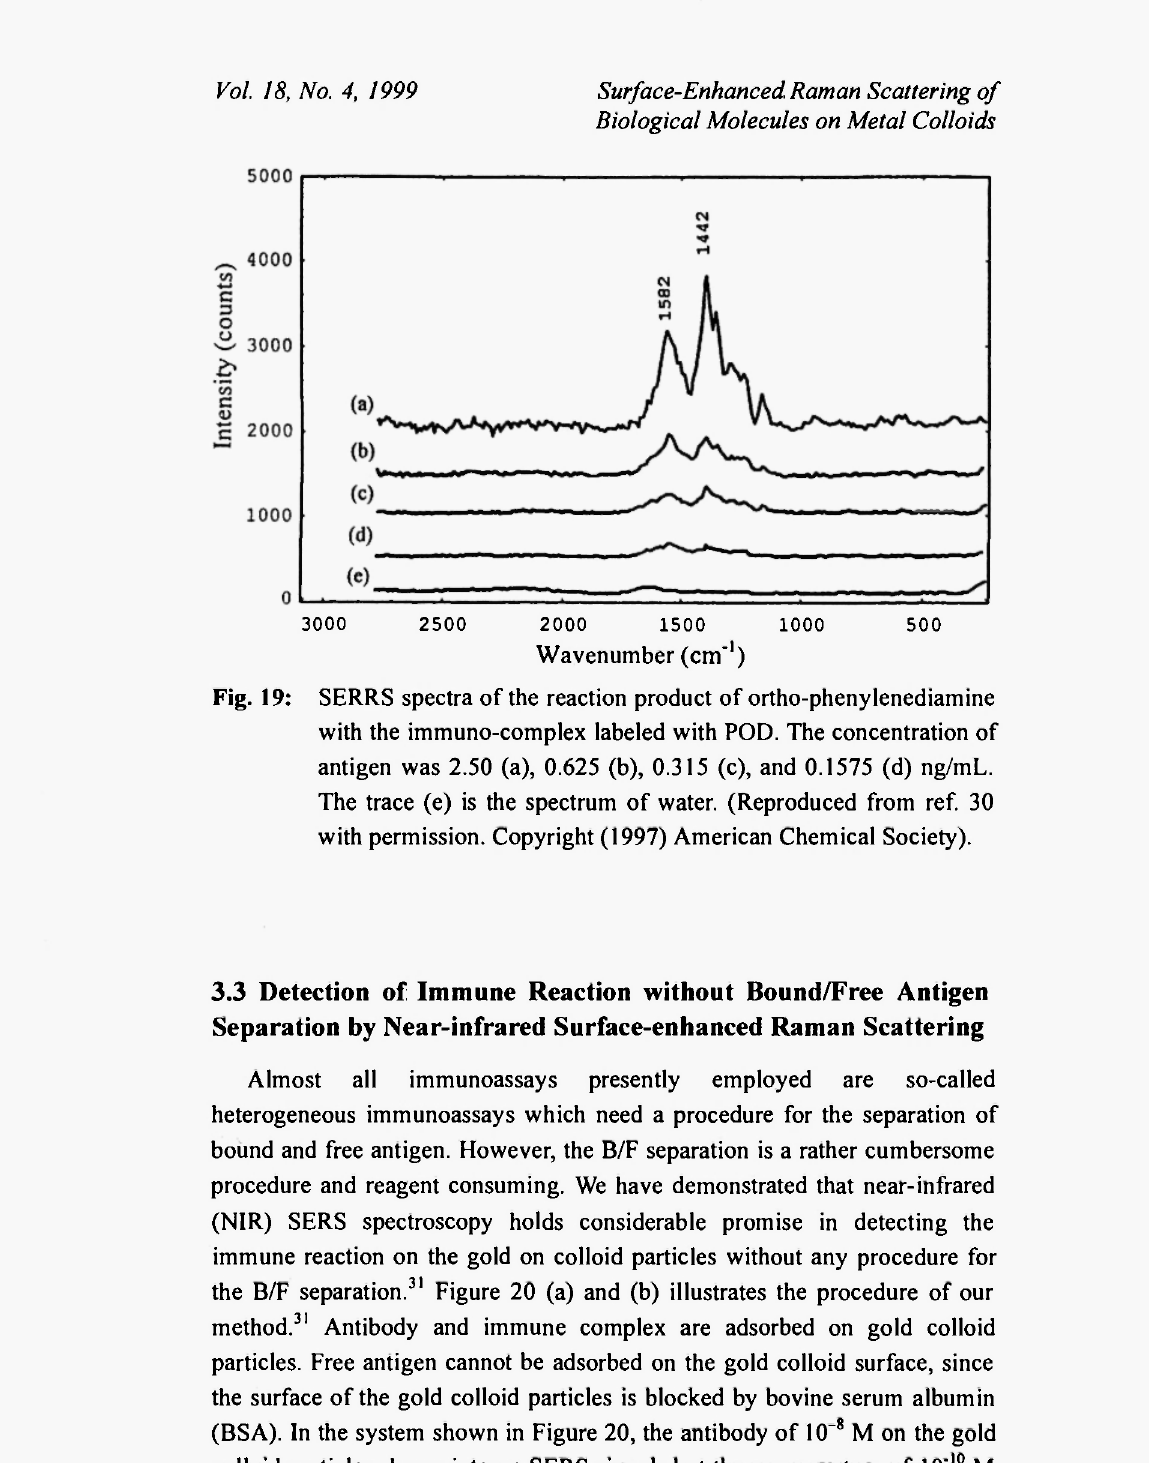
Fig. 19: SERRS spectra of the reaction product of ortho-phenylenediamine with the immuno-complex labeled with POD. The concentration of antigen was 2.50 (a), 0.625 (b), 0.315 (c), and 0.1575 (d) ng/mL. The trace (e) is the spectrum of water. (Reproduced from ref.